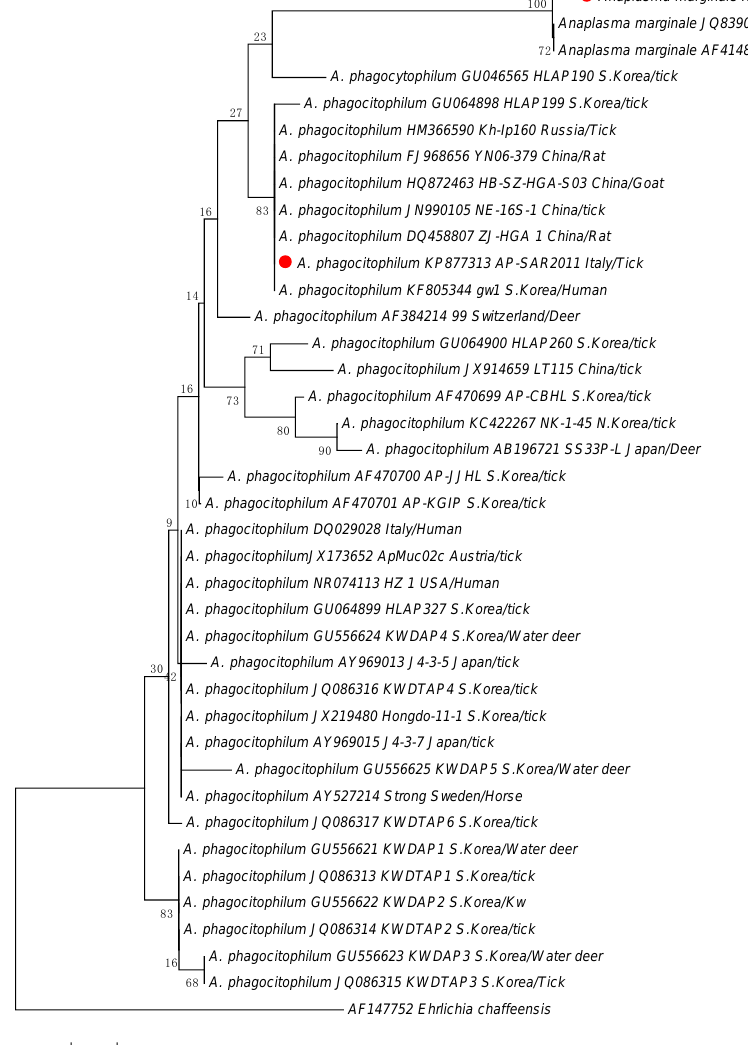
Figure 2. Phylogenetic tree based on 373-bp 16S rRNA gene of A. phagocytophilum and A. marginale strains collected in this study (red dots) compared with Anaplasma species obtained from GenBank database. The tree was constructed using the software MEGA6 and the neighbor-joining method with 1000 bootstrap re-samplings. Ehrlichia chaffeensis was used as outgroup. Country, hosts, and GenBank accession number are also indicated. Scale bar: number of base substitutions per site.